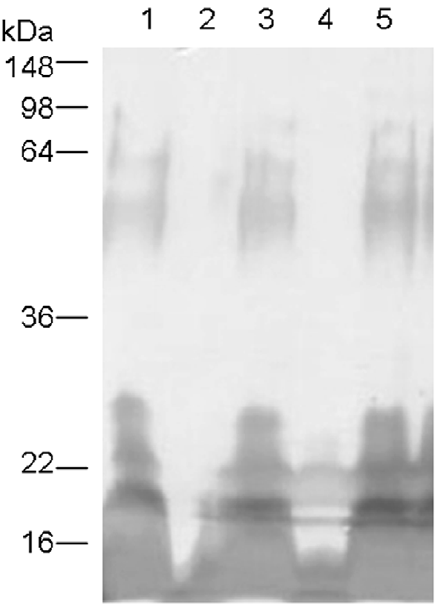
Figure 3. C. burnetii CBU0294 (PMM) restores a smooth LPS chemotype in P.aeruginosa PAO1 O5 algC mutant. SDS-PAGE and silver stain of proteinase K treated whole cell lysates of 1. wild-type P. aeruginosa PAO1, 2. P. aeruginosa algC mutant, 3. P. aeruginosa algC::tet / pLPS188 ( P. aeruginosa algC ), 4. P. aeruginosa algC::tet /pUCP20 (vector control), 5. P. aeruginosa algC::tet